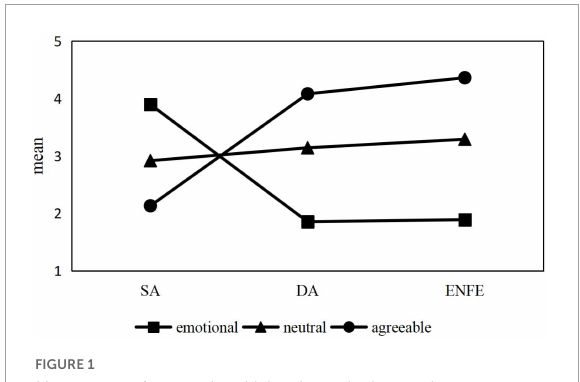
FIGURE1 Mean scores for emotional labor items by latent class.